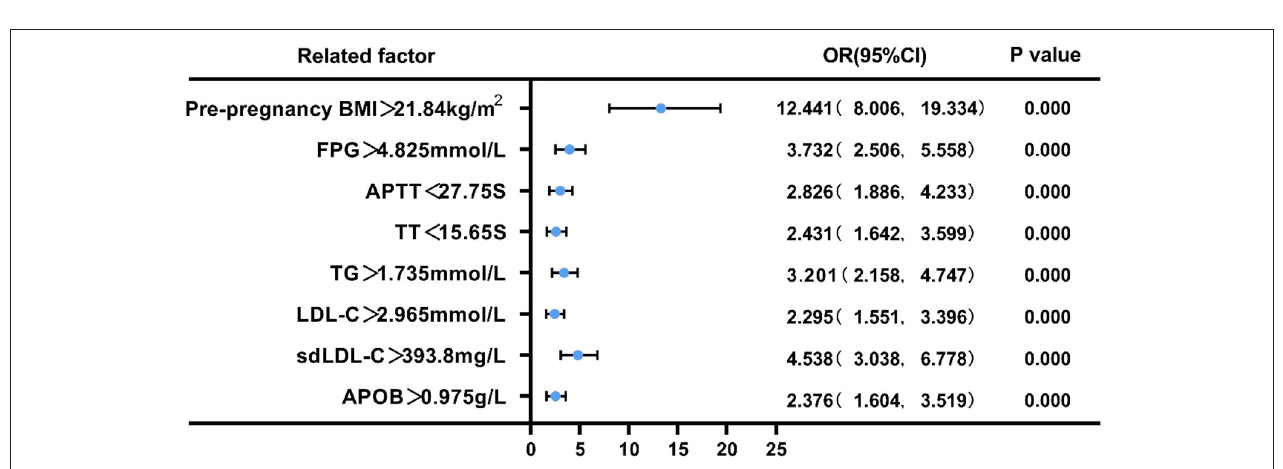
FIGURE 6 | Forest plot of the univariate logistic regression analysis of pre-pregnancy BMI, FPG, APTT, TT,TG, LDL-C, sdLDL-C, APOB in pregnant women with GDM.